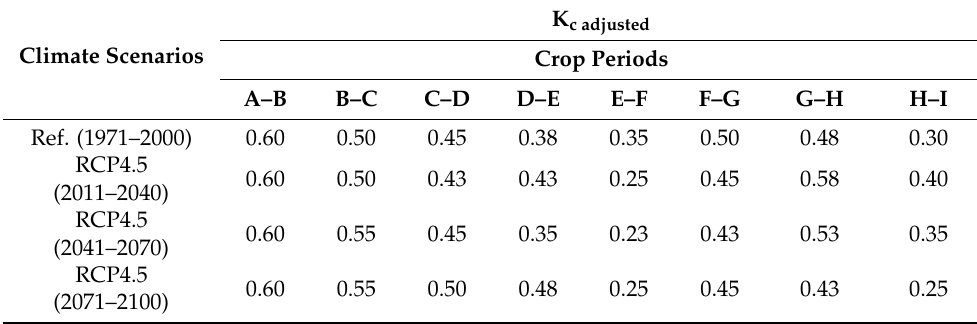
Table 6. Adjusted Kc values, for the different crop growth periods as a function of imposed water stress in the deficit irrigation management (DIM).